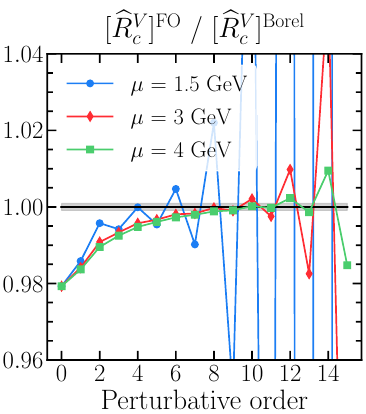
( − 1 / 3 , 1 , − 1 / 3) in large- β normalised to the 0 c